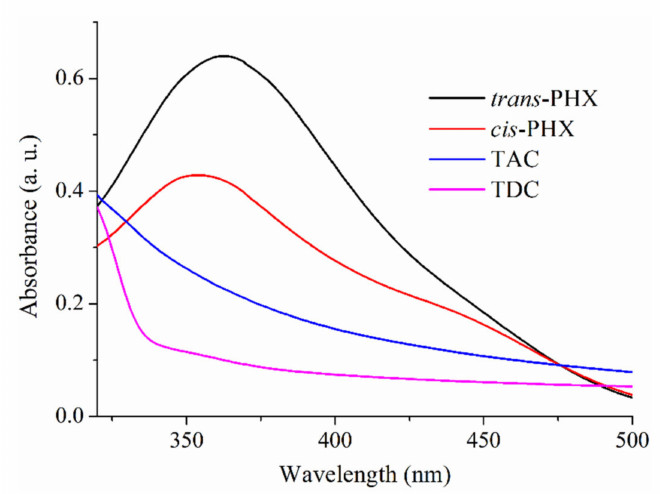
Figure 3. Absorption spectra of trans -PHX, cis -PHX, TAC and TDC at 50 µ M concentration. The fluorescence spectra of cis - and trans -PHX show increased emission upon in- creased concentration of TAC or TDC (Figure 4). The changes induced in the spectra of PHX suggest interactions between the investigated molecules. Samples with different con- centrations of the cavitand derivates (0–450 µ M) and with constant concentration of trans - and cis -PHX (50 µ M) were prepared and measured using a 366 nm excitation wavelength at 293 K, 298 K, 303 K and 308 K temperatures.